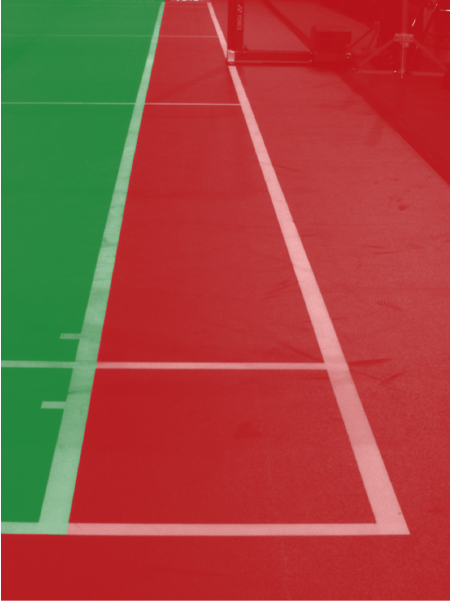
Figure 6. In and out area of a court. The green polygon represents the inside area, and the red is the outside (for the singles